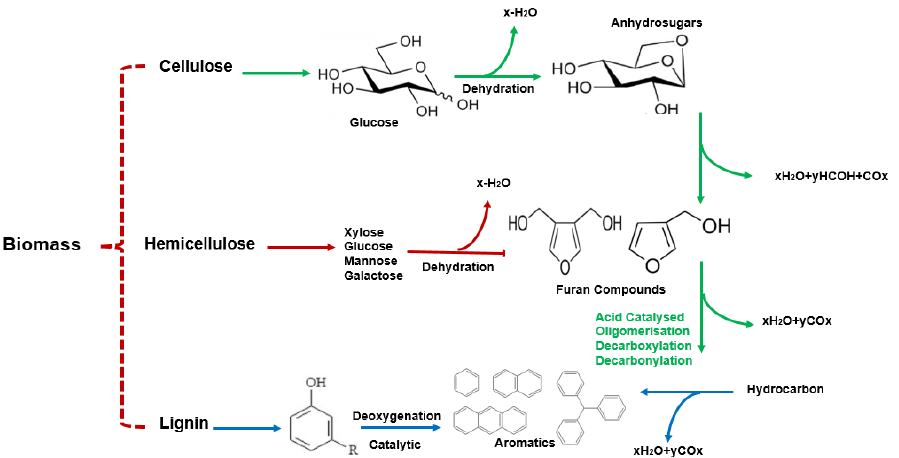
Figure 20. Generic reaction mechanism of catalytic pyrolysis of biomass (adapted from[165]).